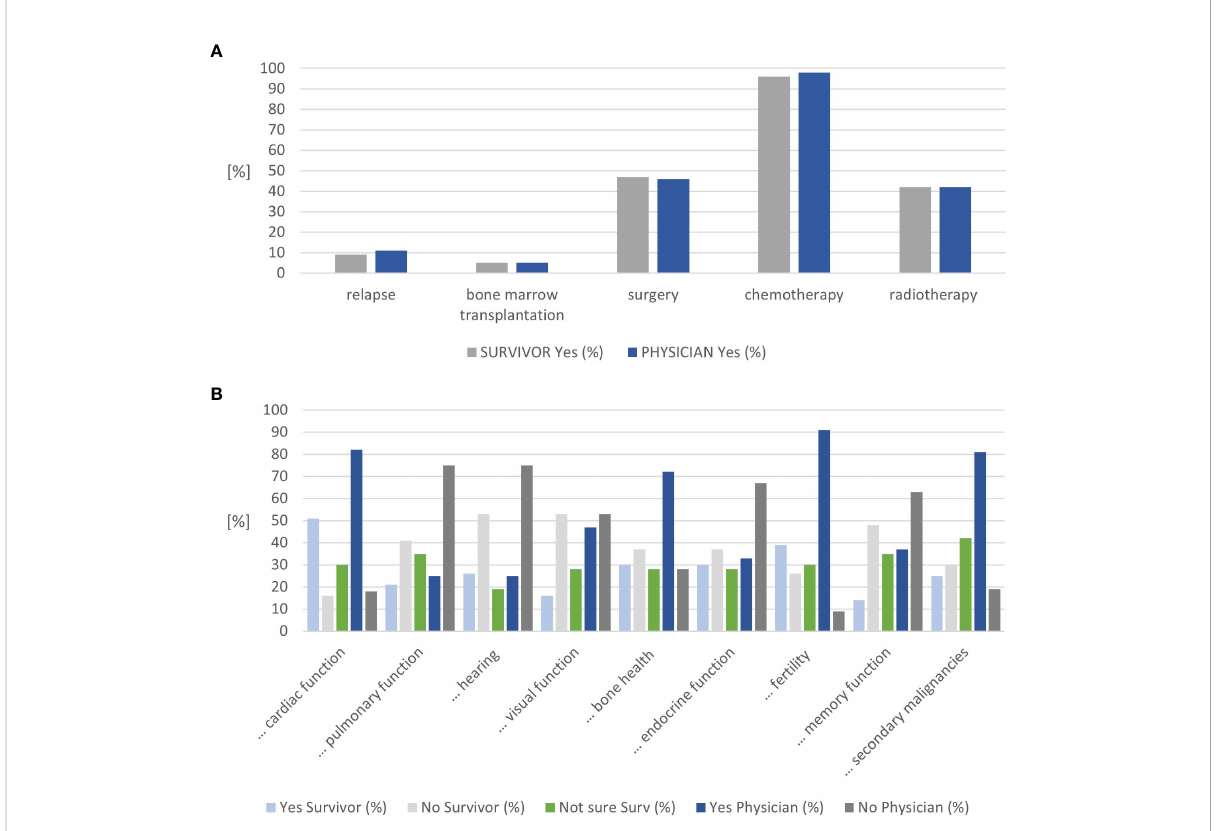
FIGURE 2 Results on cancer knowledge. (A) Congruence on treatment exposure mentioned by childhood cancer survivors and physicians. (B) Congruence on organ systems considered at risk by childhood cancer survivors and physicians (n=57).